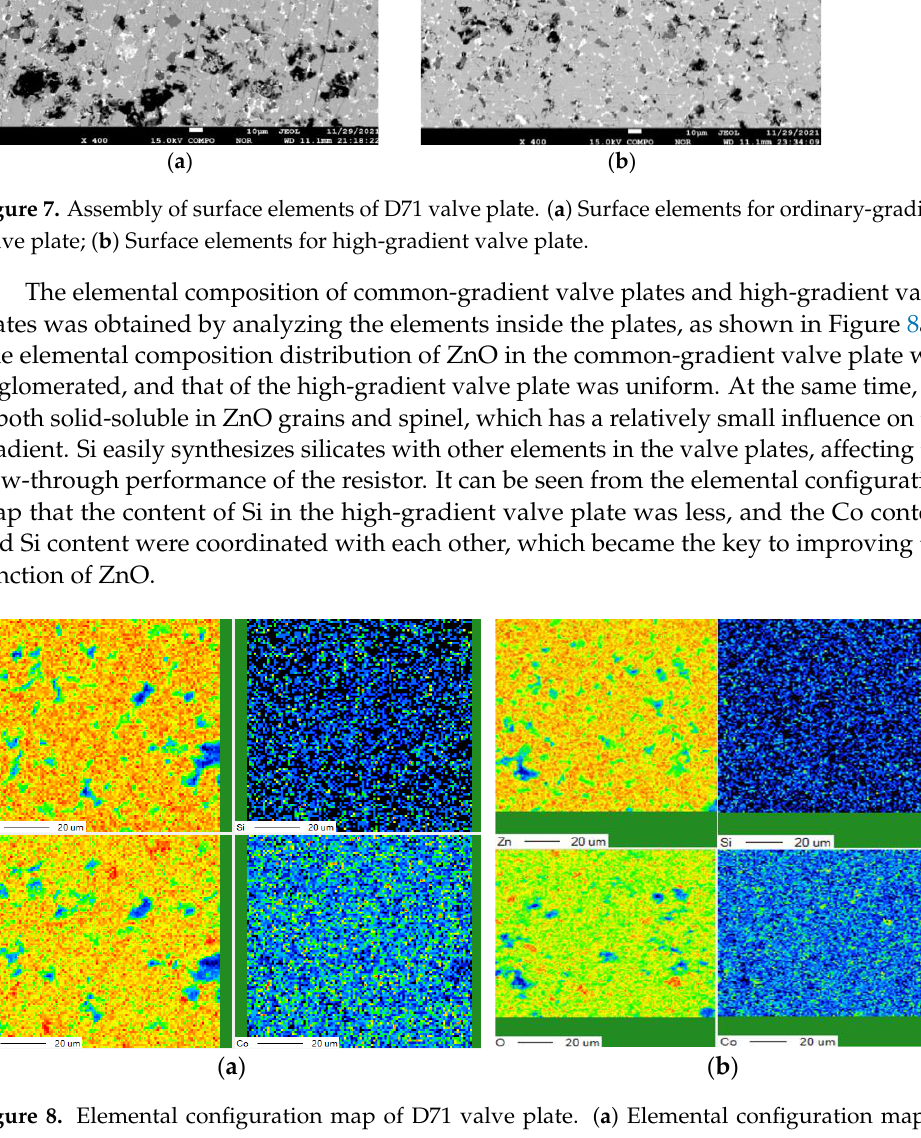
Figure 6. Surface morphology of D71 valve plates. ( a ) Surface morphology of ordinary plate; ( b )